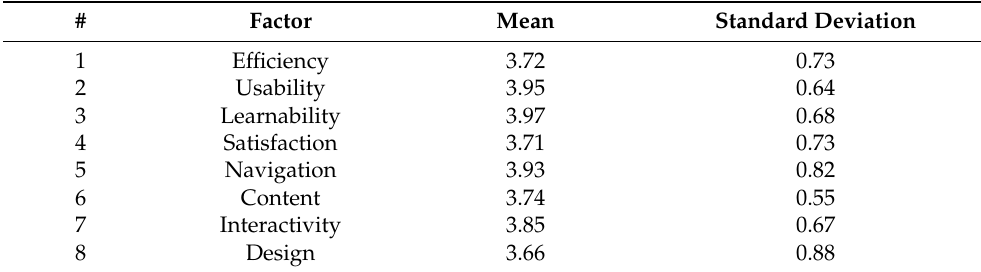
Table 5. Statistical values of evaluation